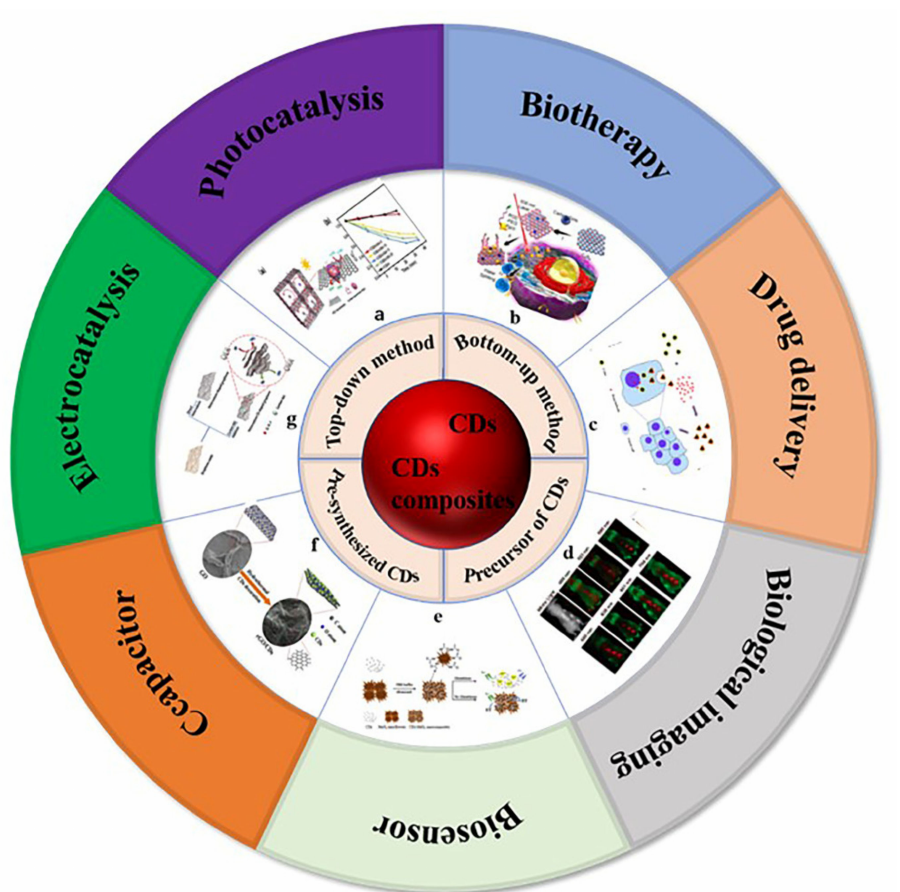
Figure 1. Preparation methods and application classification of carbon dots and carbon dots com- posites. ( a ) Photocatalysis: Photocatalytic mechanism of 3D CQDs/GA composites, photocatalytic reduction of Cr (VI) with different proportions of CQDs/GA and original CQD [4]. ( b ) Biotherapy: Structure of PCCN and schematic diagram of 630 nm light-driven water splitting enhanced PDT [5]. ( c ) Drug delivery: Image of fluorescent carbon nanoparticles in medical cancer treatment [6]. ( d ) Bio- logical imaging: In vivo imaging and biodistribution of the carboxylated Graphene Quantum Dots [7]. ( e ) Biosensor: Schematic diagram of GSH detection of CD-MnO 2 nanocomposites [8]. ( f ) Capacitor: Schematic diagram of synthesis process of three-dimensional interconnected CD decorative reduced graphene oxide nanosheets (rGO/CDs) [9]. ( g ) Electrocatalysis: Schematic preparation process of NS-CD@gf